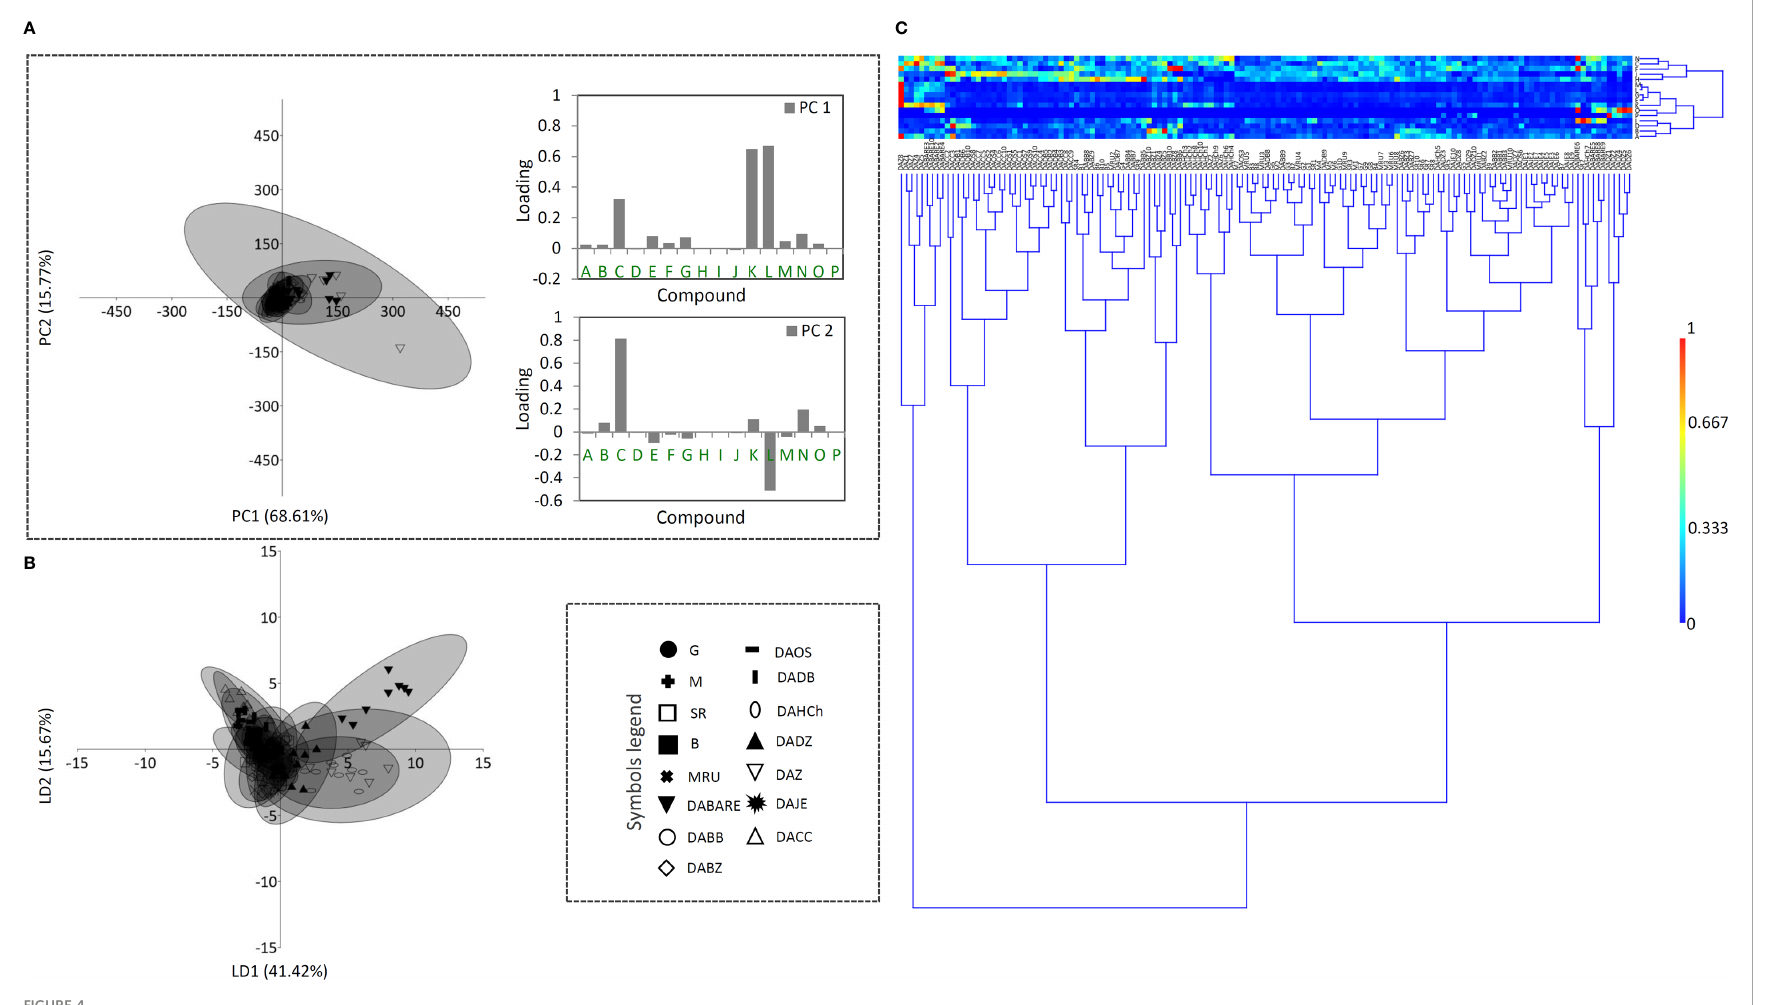
FIGURE 4 Principal component analysis (PCA) biplot with the fi rst two PCs explaining 84.38% of the total variance (A) among D. grandi fl ora accessions. For fi fteen D. grandi fl ora populations (each labeled by a different symbol) 95% con fi dence ellipses are presented. Participation of the variables (compounds) in the fi rst two PCs is indicated by the corresponding loading plots. Linear discriminant analysis (LDA) (B) represents the same fi fteen populations of D. grandi fl ora with 95% con fi dence ellipses. Heatmap of the scaled quantitative data (C) with the samples arranged according to the hierarchical cluster analysis (Ward ’ s method of cluster agglomeration). Compounds ’ labels are the same as in Figure 3. For the interpretation of population abbreviations in the fi gure legend, please refer to Table